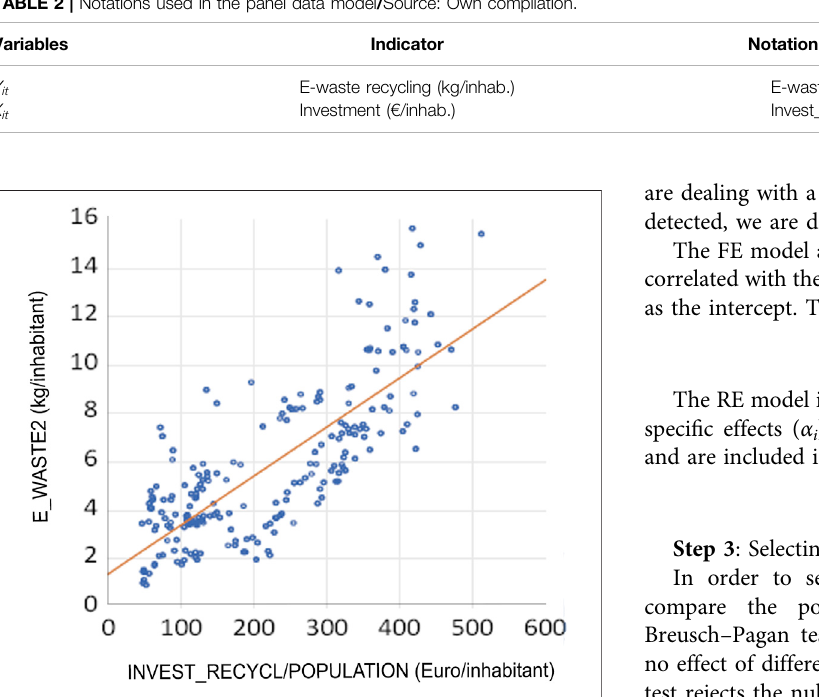
Frontiers in Environmental Science |